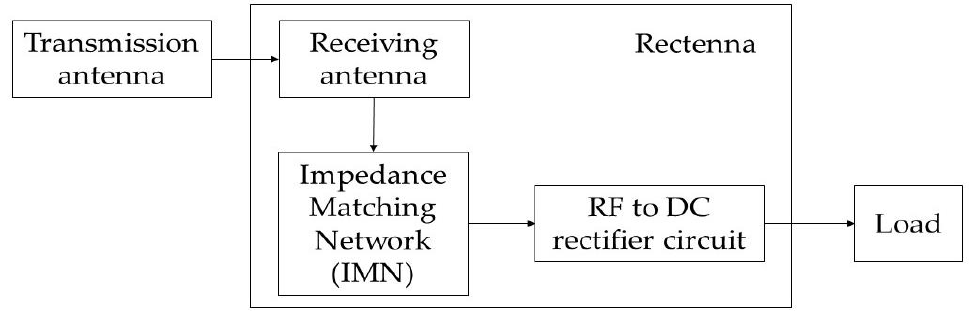
Figure 1. RF energy harvesting system [14].